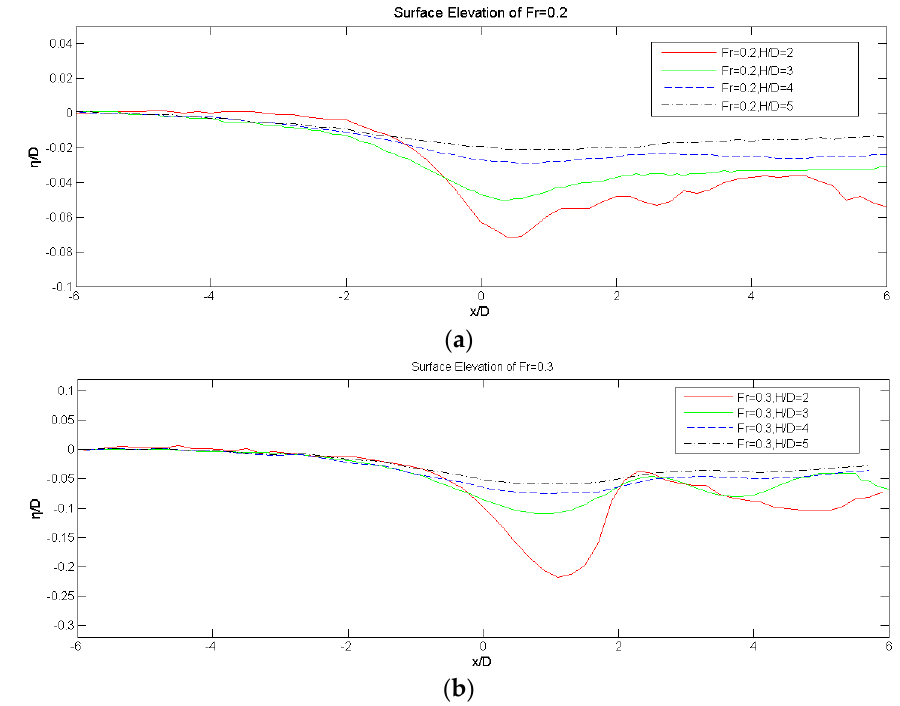
Figure 13. The free surface profile of Froude number, ( a ) Fr = 0.2; ( b ) Fr = 0.3.